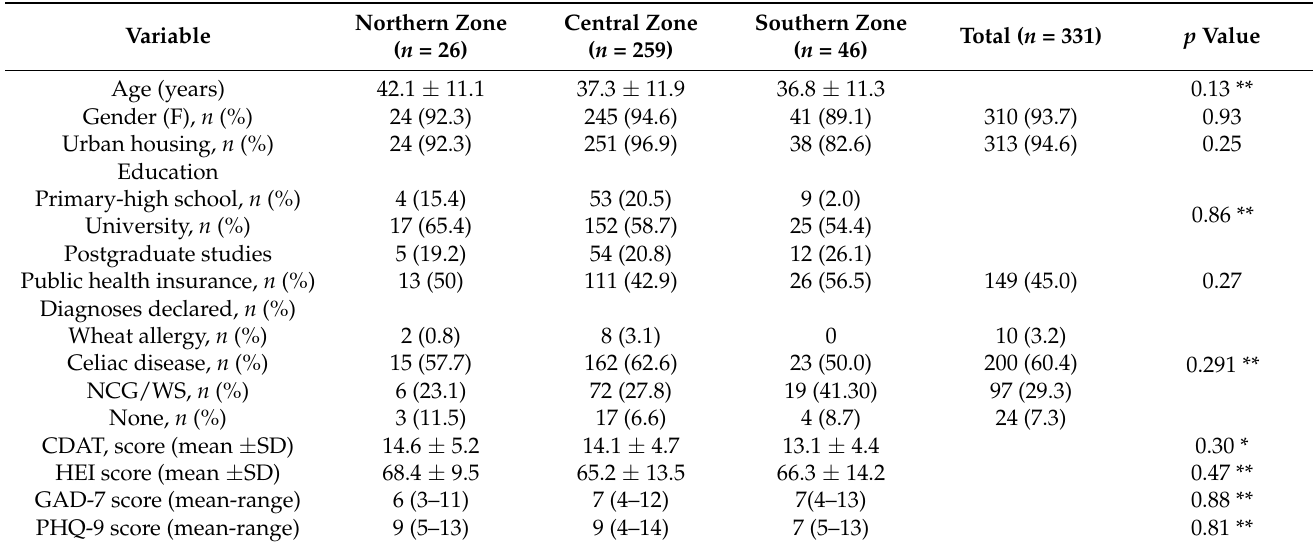
Table 1. General characteristics, diagnoses declared, and mean group scores in dietary and mental health tests by geographic zone of origin of